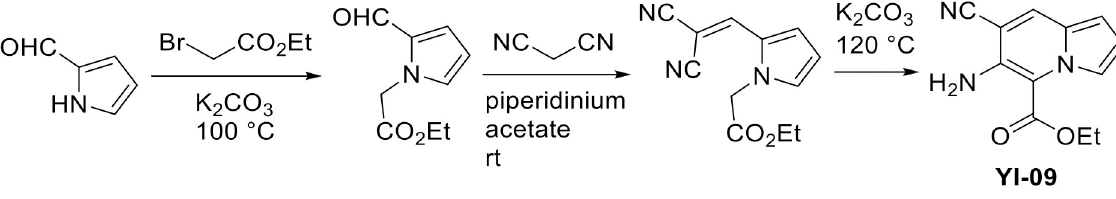
Fig 7. A scheme of synthesizing